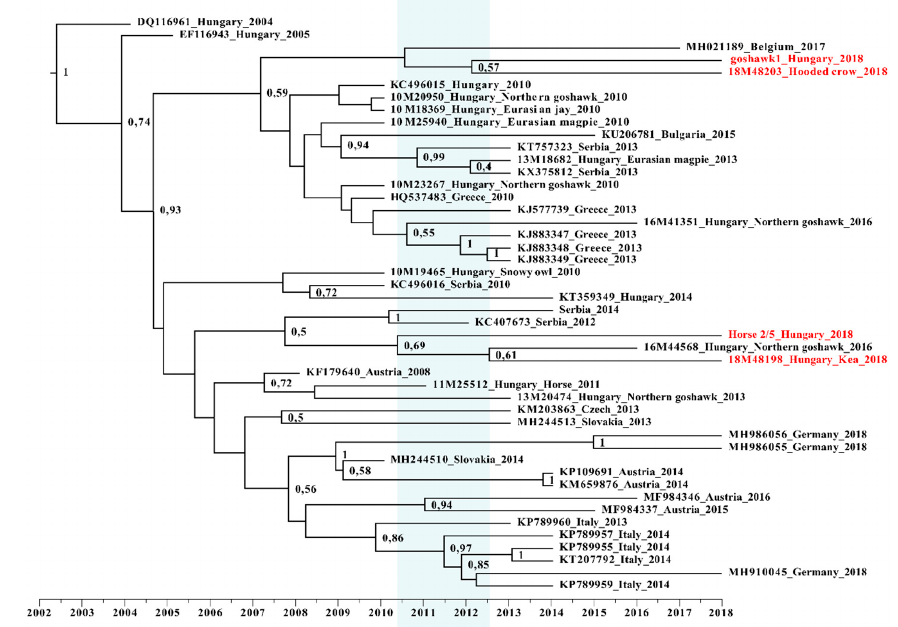
Figure 6. Time-calibrated Bayesian maximum clade credibility phylogenetic reconstruction of the evolution of Hungarian wild bird and horse samples. Partial NS5 gene sequences of this study, along with cognate sequences, were included in this dataset. Samples from 2018 are highlighted with red color, while the timeframe of origin is indicated with blue background.